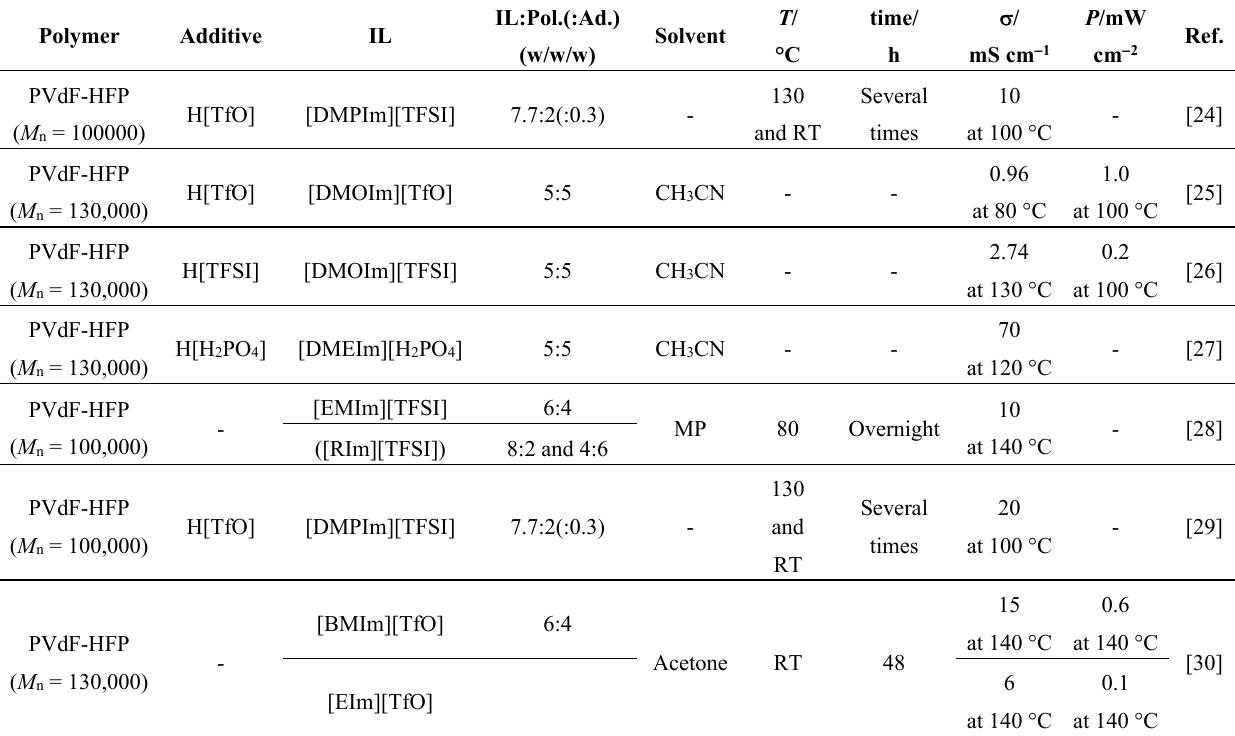
1. IL/PVdF-HFP composite